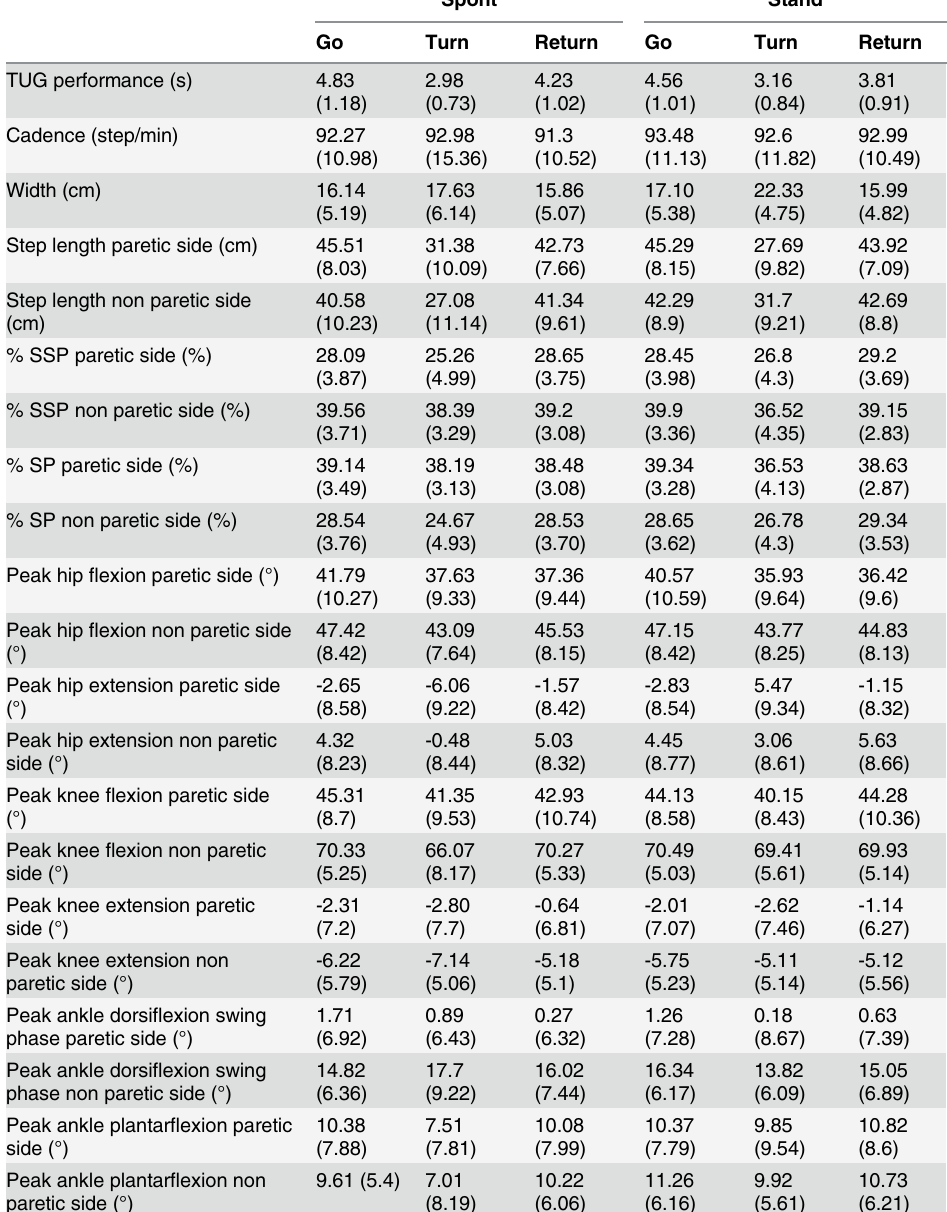
Table 2. TUG performance and spatiotemporal and kinematic parameters for each sub-task and both conditions (Spont and Stand). Spont